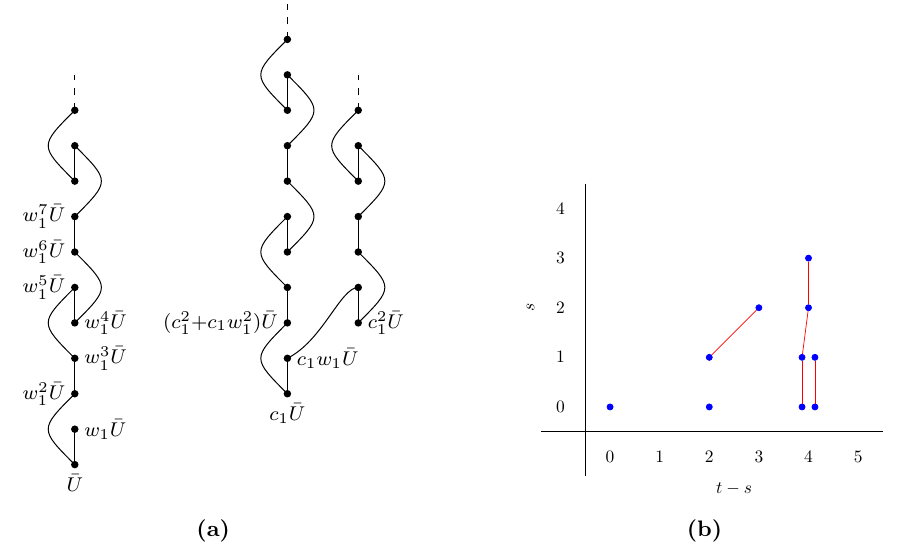
Figure 5. (a) The A 2 (1) -module structure for Σ H • ( MTO 1 ) ⊗ H • ( BU (1)) and (b) its corresponding Adams chart.